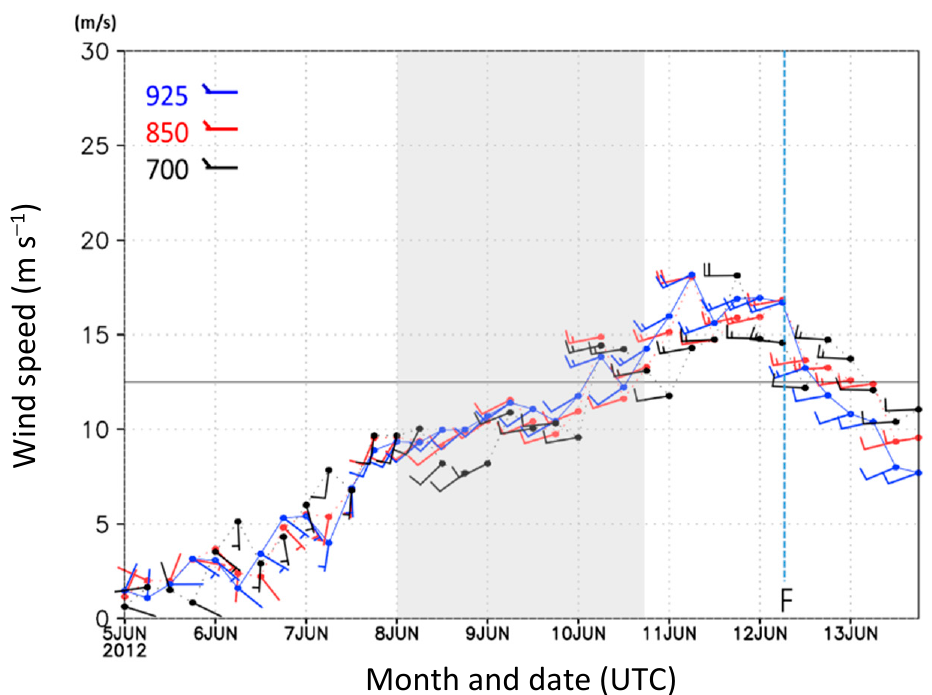
Figure 9. The time series of horizontal winds (m s − 1 , barbs, full barb = 10 m s − 1 ) in the ERA-Interim analysis at 925 (blue), 850 (red), and 700 hPa (black), respectively, averaged inside the blue box in Figure 1 in the upstream area of Taiwan, from 0000 UTC 5 to 1800 UTC 13 June 2012. The symbol “F” marks the time when the surface front reached northern Taiwan.